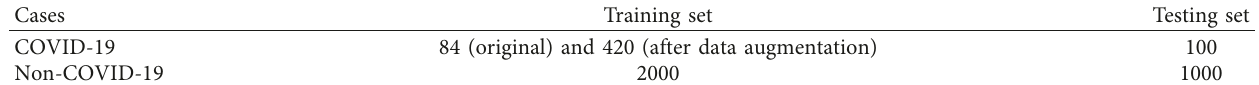
Table 1: Images selected from the COVID-Xray-5k dataset.